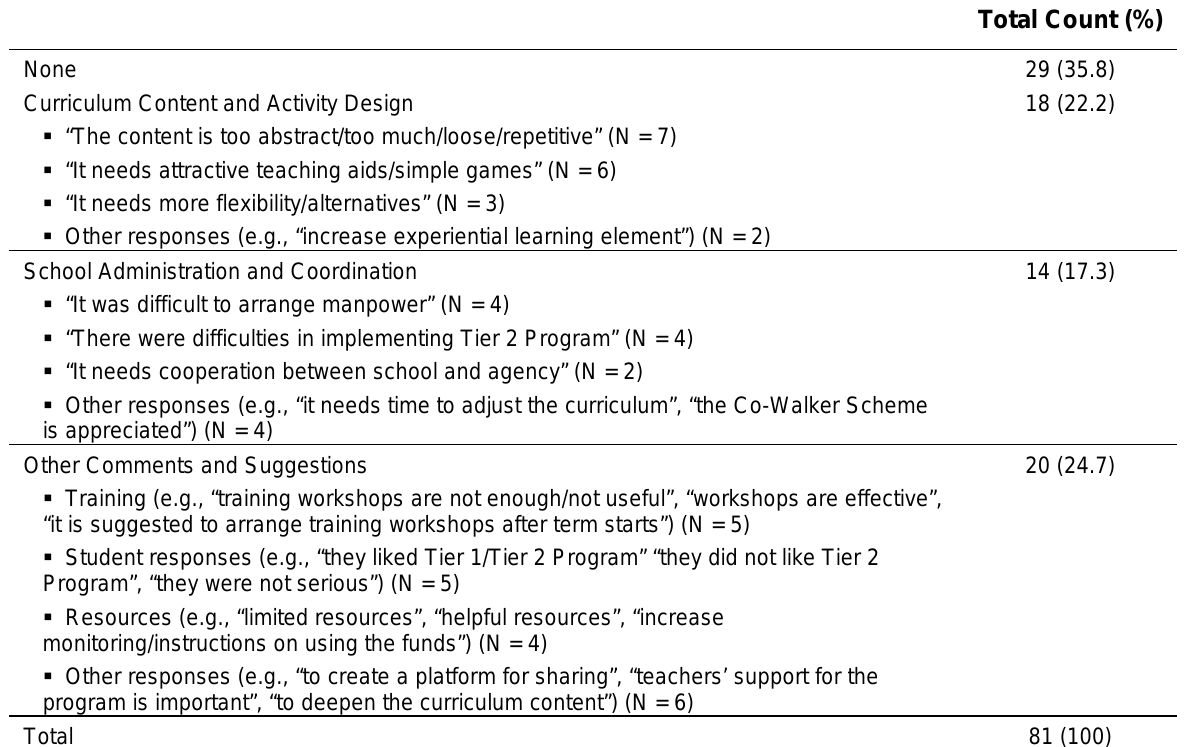
Other Opinions of the Project (Secondary 1